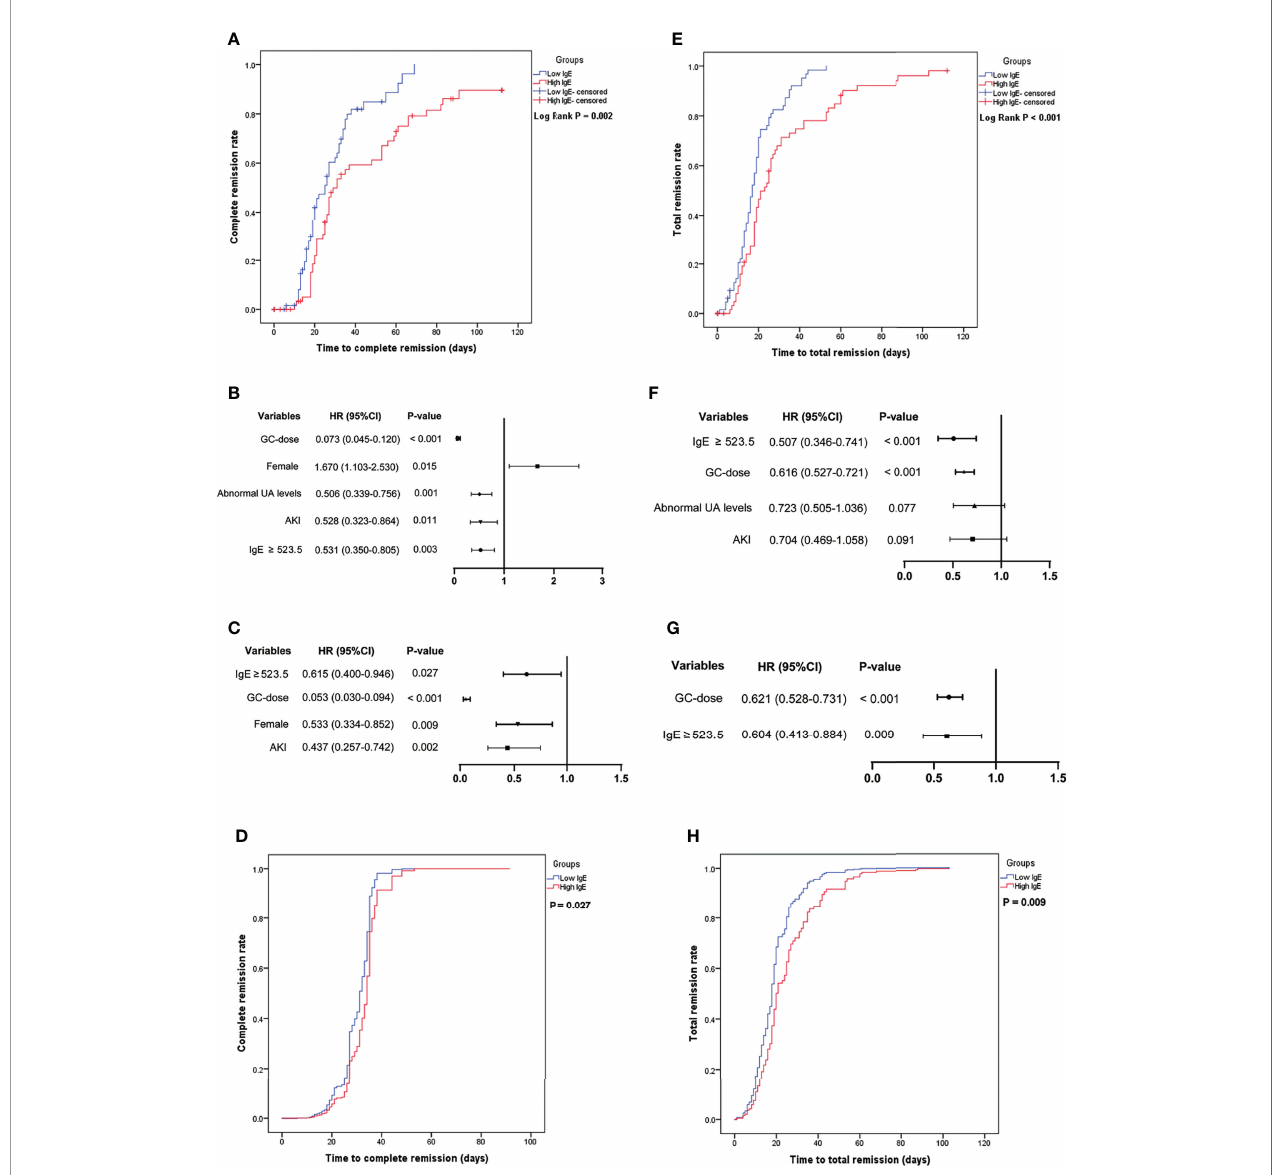
FIGURE 2 | The cumulative remission rate of minimal change disease (MCD) in the low- and high-IgE groups and the identi fi cation of independent correlation factors for remission. (A) Cumulative complete remission rate. Independent correlation factors for complete remission by univariate (B) and multivariate (C) cox regression analysis. (D) Serum IgE levels were independent correlation factors for complete remission of MCD. (E) Cumulative total remission rate. Independent correlation factors for total remission by univariate (F) and multivariate (G) cox regression analysis. (H) Serum IgE levels were independent correlation factors for total remission of MCD. AKI , acute kidney injury; GC-dose , the dosages of glucocorticoids; MCD , minimal change disease, and UA , uric